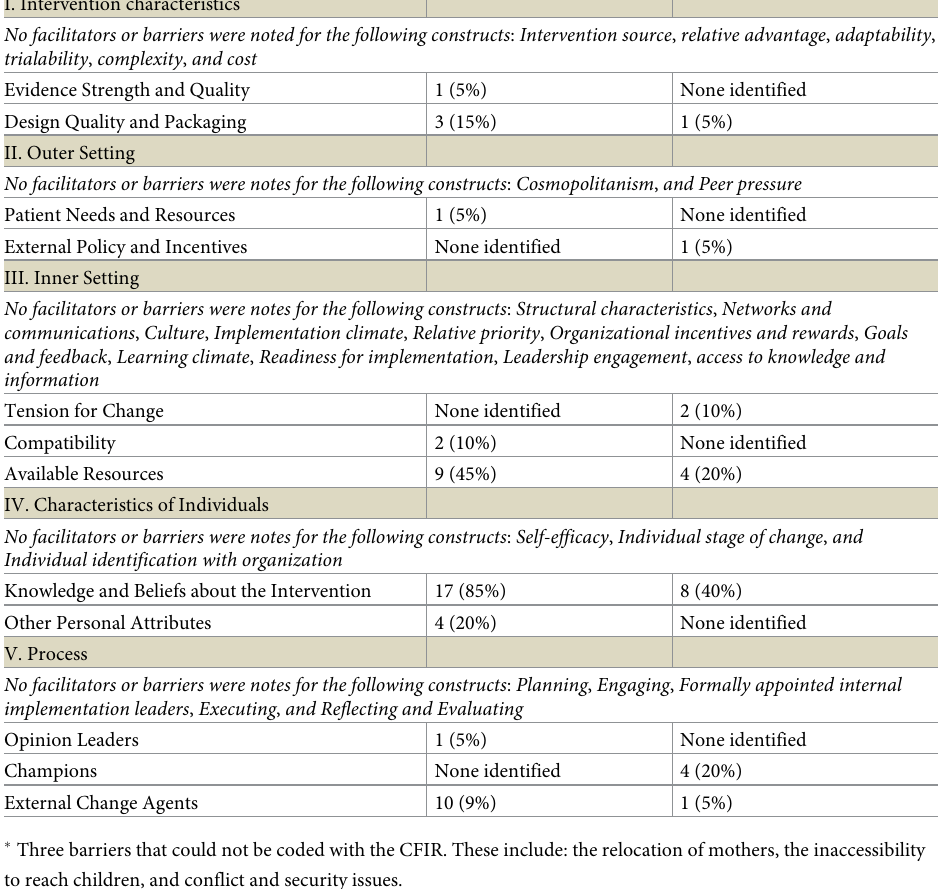
Table 2. Frequency table of study-identified barriers � and facilitators (n = 20). CFIR domains (n = 5) and constructs (n =